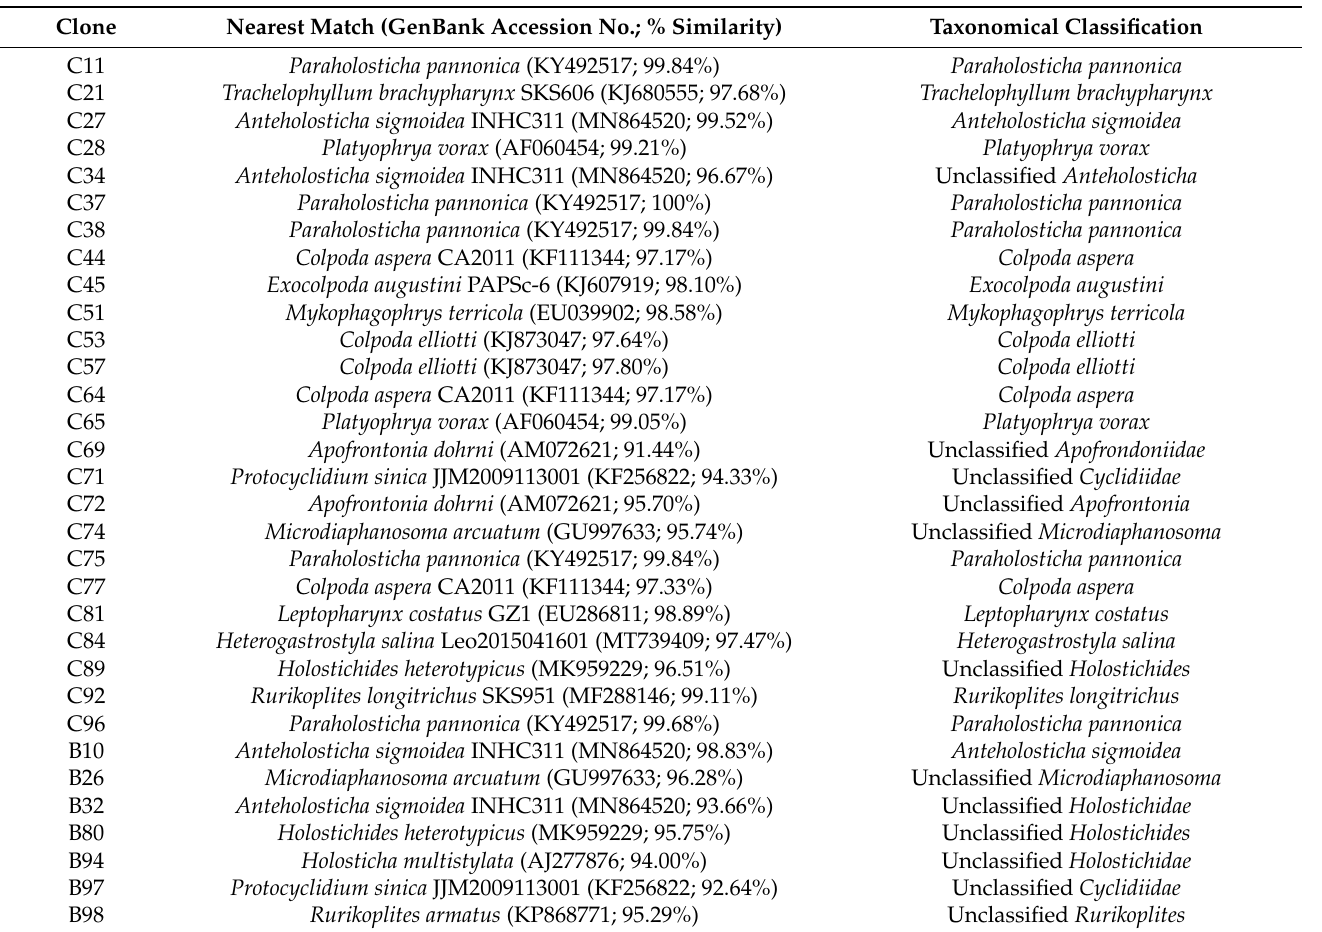
Table 4. BLAST analysis of 18S rDNA fragments selected from Pratomagno DGGE and belonging to the Ciliophora Phylum. The sequence coverages of the nearest matches were always 100%. The taxonomical identification was achieved by using different sequence similarity thresholds: a similarity of ≥ 97%, ≥ 95%, ≥ 90%, ≥ 85%, ≥ 80%, and ≥ 75% for assignment at the species-, genus-, family-, order-, class-, and phylum-level identification, respectively